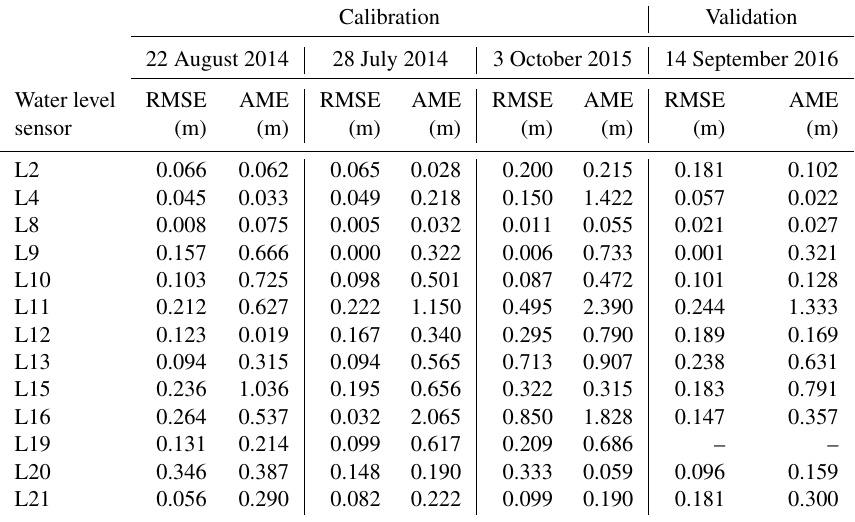
Table 2. Root mean square error (RMSE) and absolute maximum error (AME) for the calibration and validation